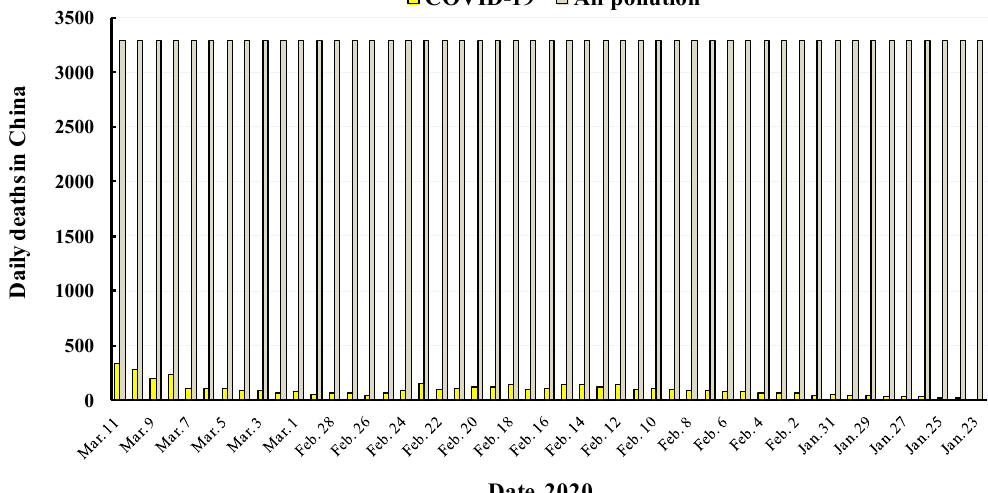
Fig. 13: Actual daily deaths due to COVID-19 vs. averaged daily deaths due to poor air quality in China (WHO, 2020b)